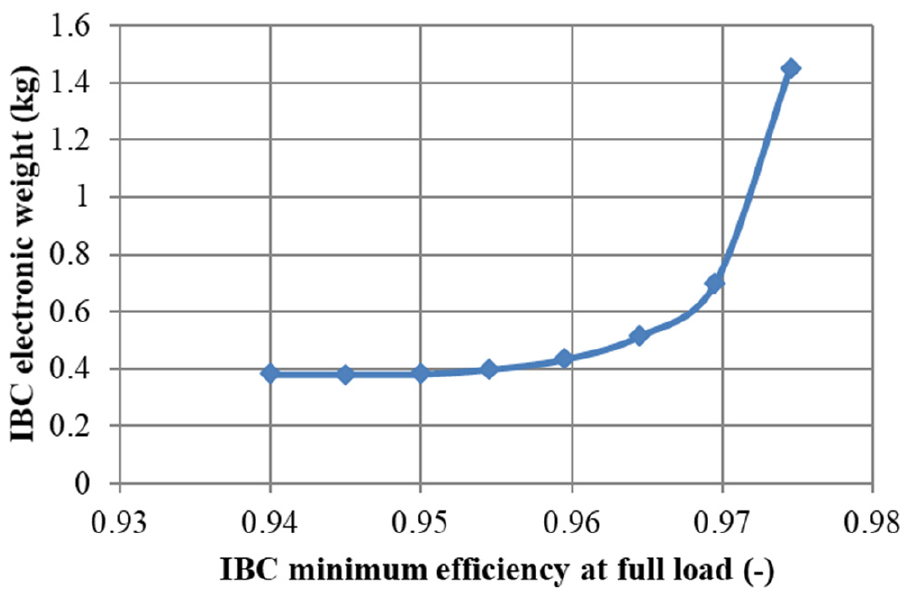
Figure 17. Pareto front between the weight and the efficiency of the IBC in DCM mode with MPP 60 material for phase inductor core based on the initial set of specifications of Table 1.